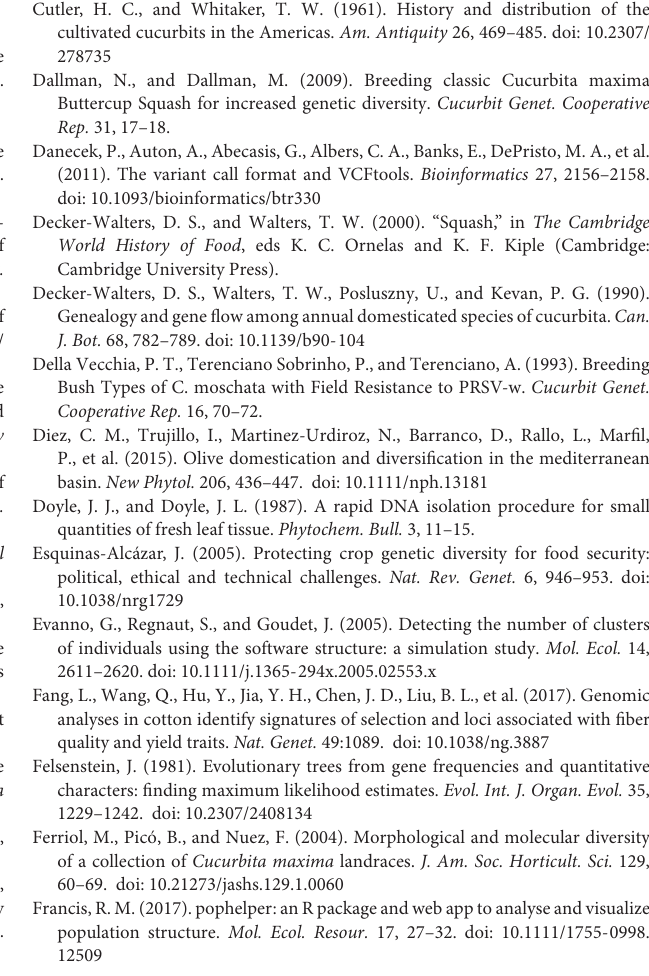
C. maxima (A) and C. argyrosperma (B) for values of K =1 through 6. Supplementary Table 1 | Accession information for samples included in this study. Supplementary Table 2 | STRUCTURE ancestry coefficients per accession for values of K =2, 4, and 5. These values correspond to the bar graph in Figures 2A,B . Note that the population number is assigned arbitrarily by STRUCTURE and independently between species-level analyses. The column headers denote which population corresponds to which color in Figure 2 . Supplementary Table 3 | Domestication features in landrace and improved C. maxima ssp. maxima and C. argyrosperma ssp. argyrosperma based on loci with F ST and π log-ratio above thresholds determined by our outlier tests. Supplementary Table 4 | Significantly enriched full GO terms and GO slim terms identified for C. maxima and C. argyrosperma